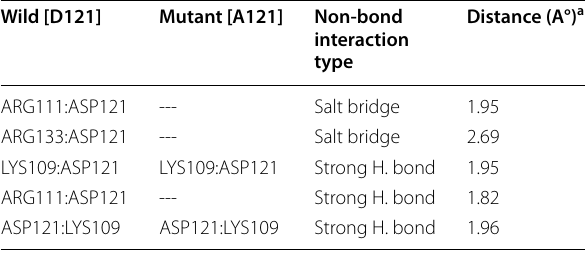
a Under steric bump; VDW fraction max. dist. of weak H. bonds